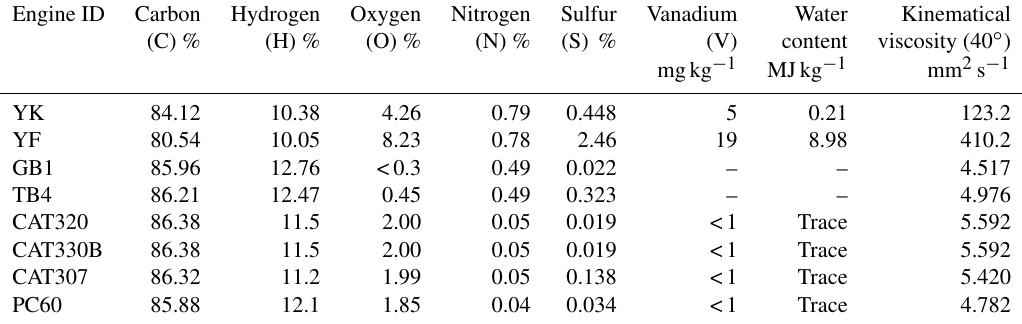
Table 2. Results of the fuel quality